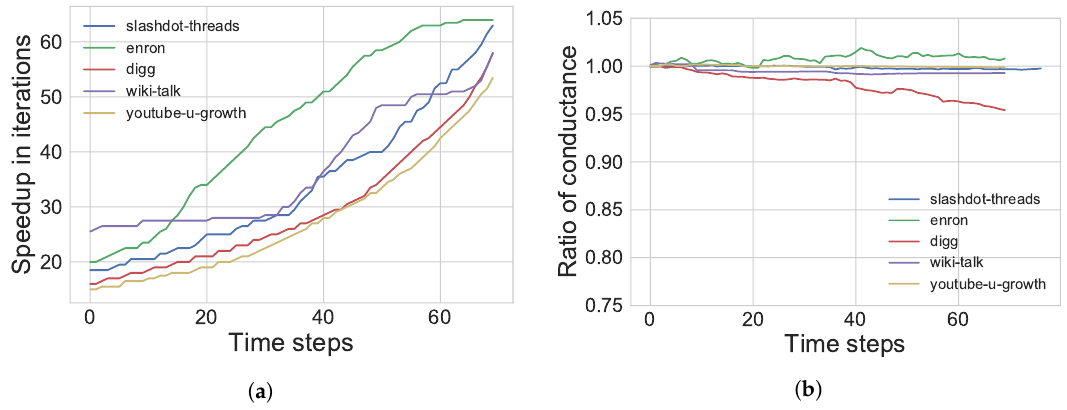
Figure 3. Performance and quality behavior of dynamic algorithm compared to static recomputation over time. ( a ) speedup in iterations over time for b = 10, ( b ) ratio of conductance scores over time for b =